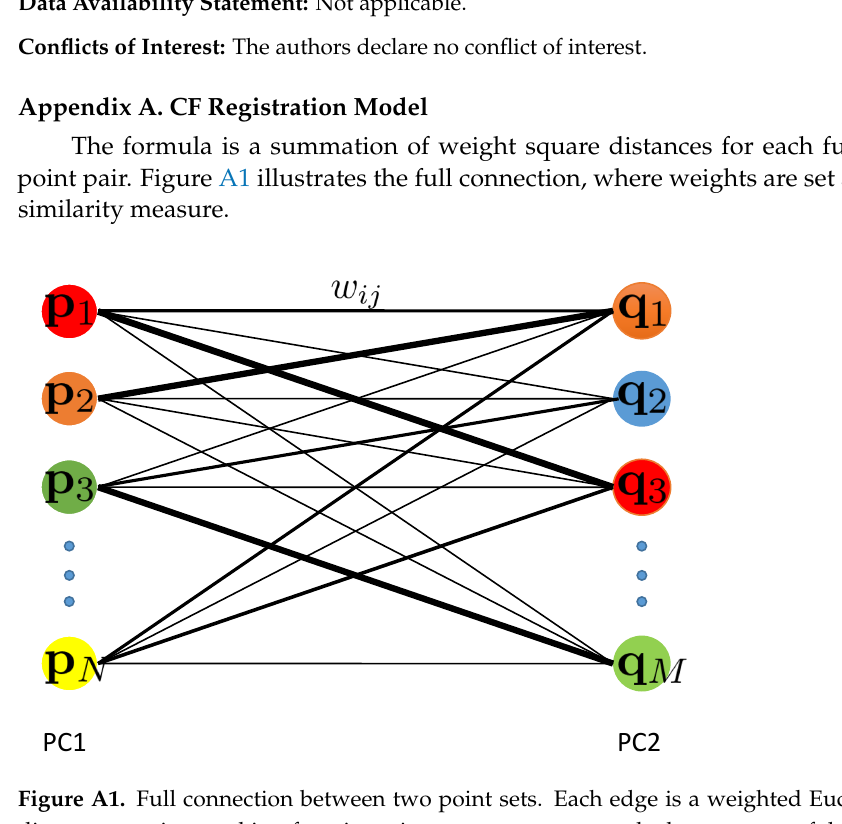
Figure A1. Full connection between two point sets. Each edge is a weighted Euclidean squared distance term in our object function, given a proper w i , j to scale the cost term of the pair ( i , j ) . The thickness of the lines reflect the similarity (weight) of